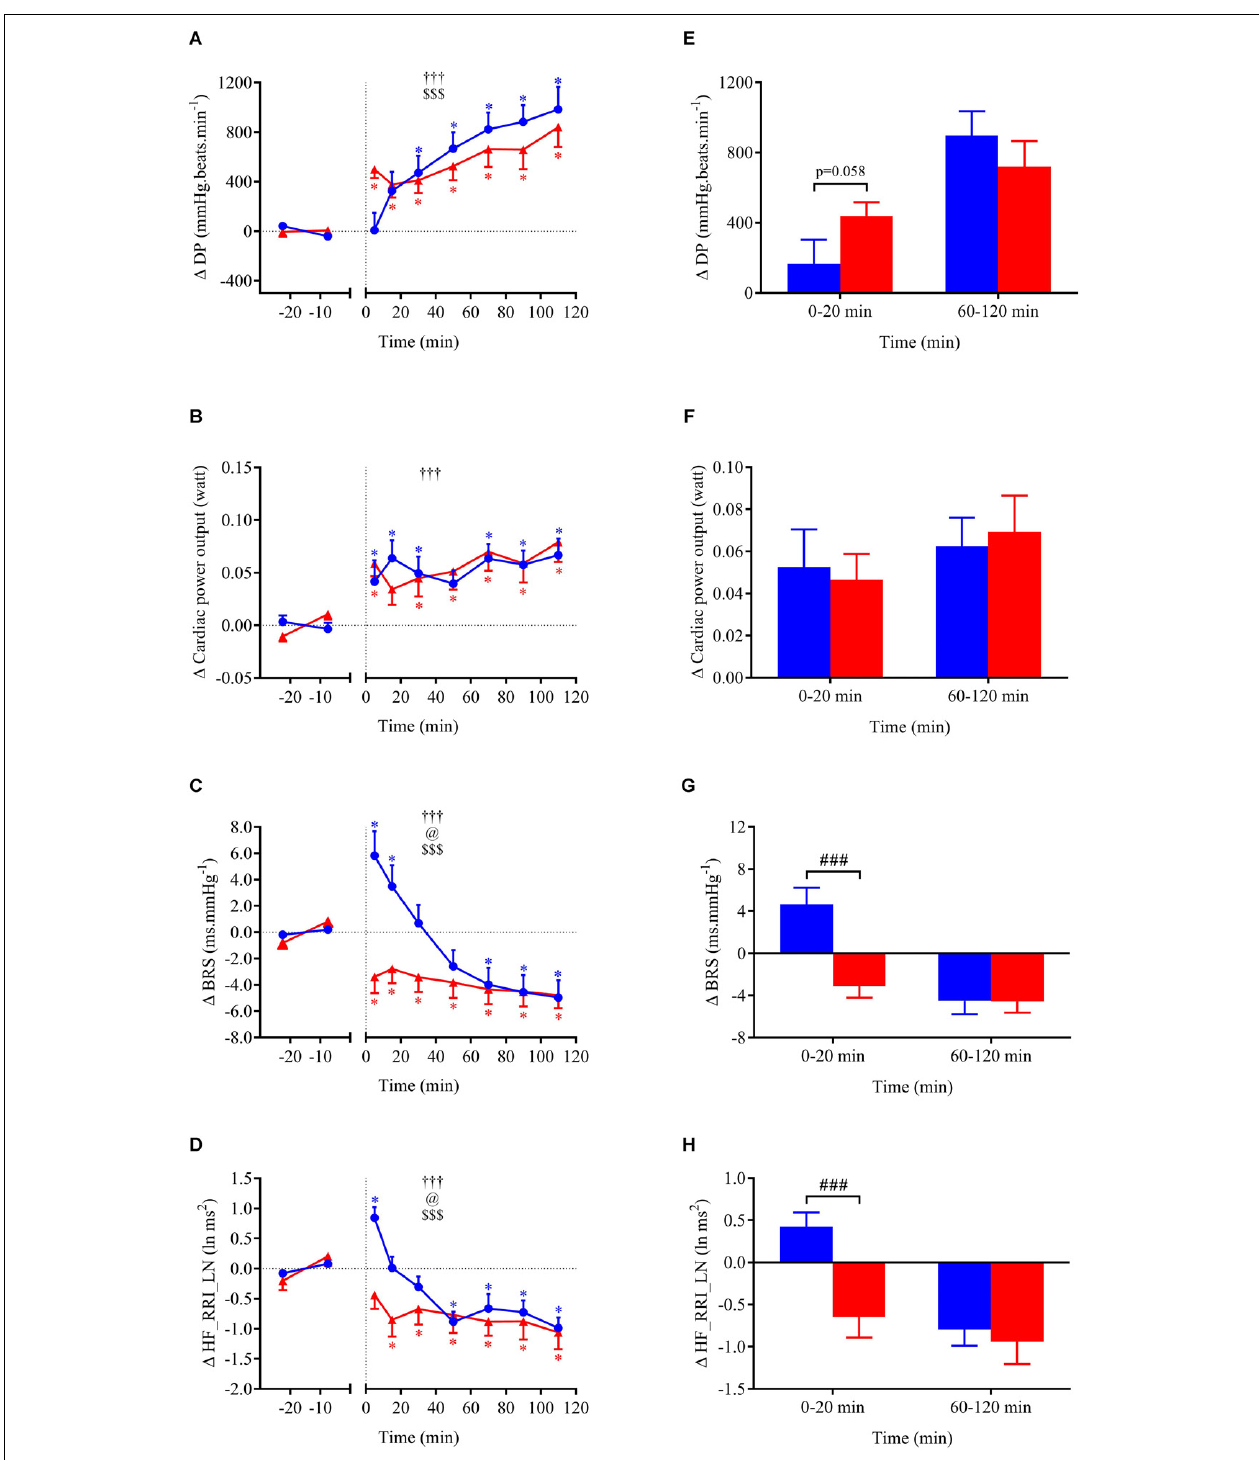
FIGURE 5 | (A–D) Time course of the changes in double product (DP), cardiac power output (CPO), baroreflex sensitivity (BRS), and high-frequency power components of RR intervals (HF_RRI_LN) presented as delta (i.e., absolute changes relative to baseline levels). (E–H) Mean responses averaged over 0–20 and 60–120 min post-drink periods presented as delta (i.e., average over 0–20 and 60–120 min post-drink minus the average over the 30-min baseline period, respectively). Drinks: cold wine ( , ); hot wine ( (cid:78) , ). Values are mean ± SEM. Symbols for ANOVA analysis: † , time effect; @, temperature effect; and $, time × temperature interaction effects. See legend of Figure 4 for level of significance. (cid:32)